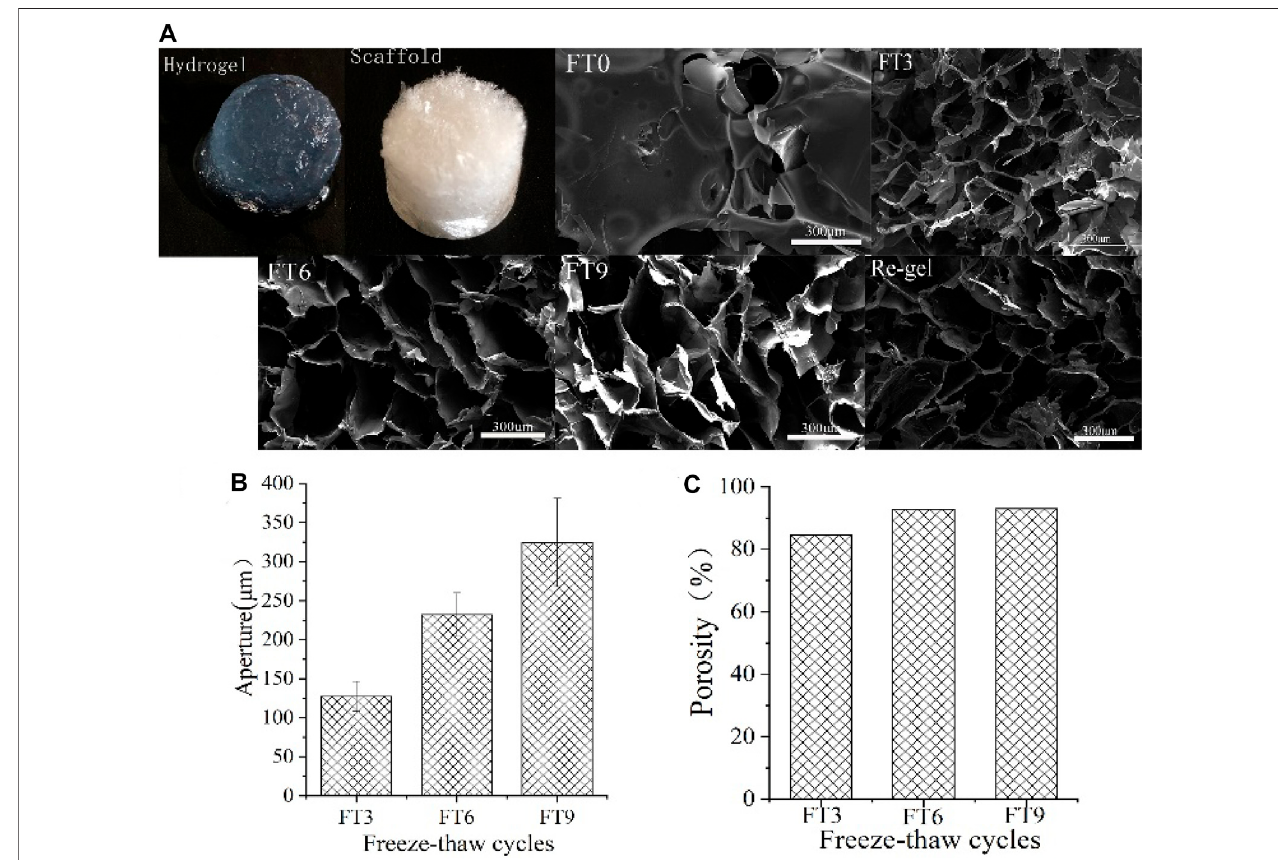
FIGURE 2 | (A) SEM images, (B) pore size distribution, and (C) porosity.